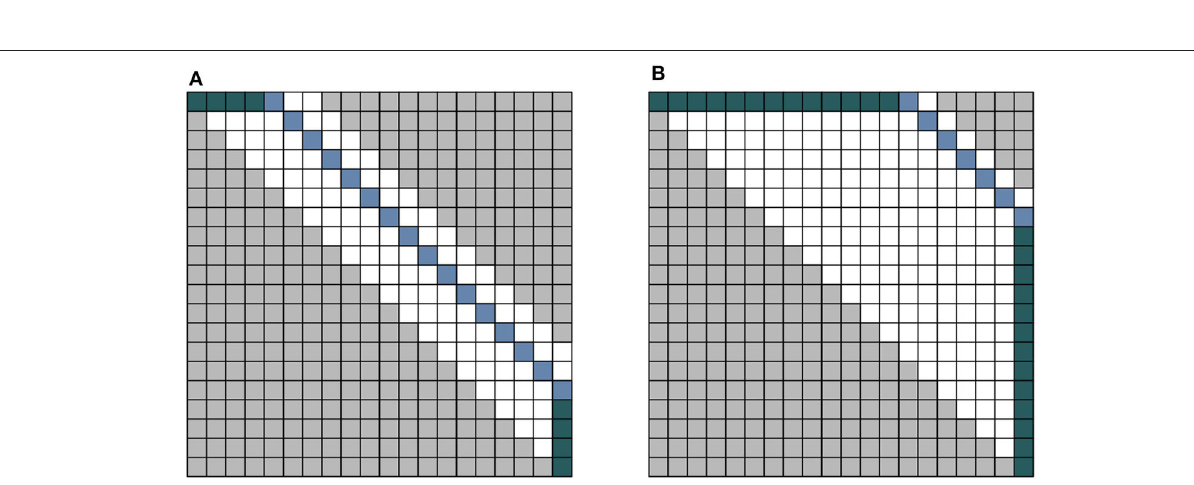
FIGURE 7 | An illustration of a potential problem with the measure. (A) Illustrates the result for a persistence model with a small time-shift. (B) Illustrates the case of a persistence model with a large time shift. When the time series is too small, the counts will be dominated by the green-colored block, while the actual truth will appear very small due to